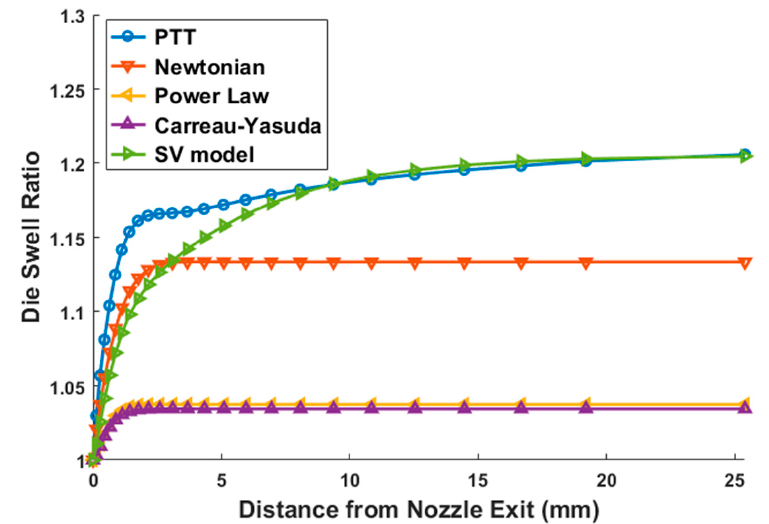
Figure 8. Die swell profiles predicted by using different rheology models. Table 3. Apparent swell ratio values resulted by applied rheology models.